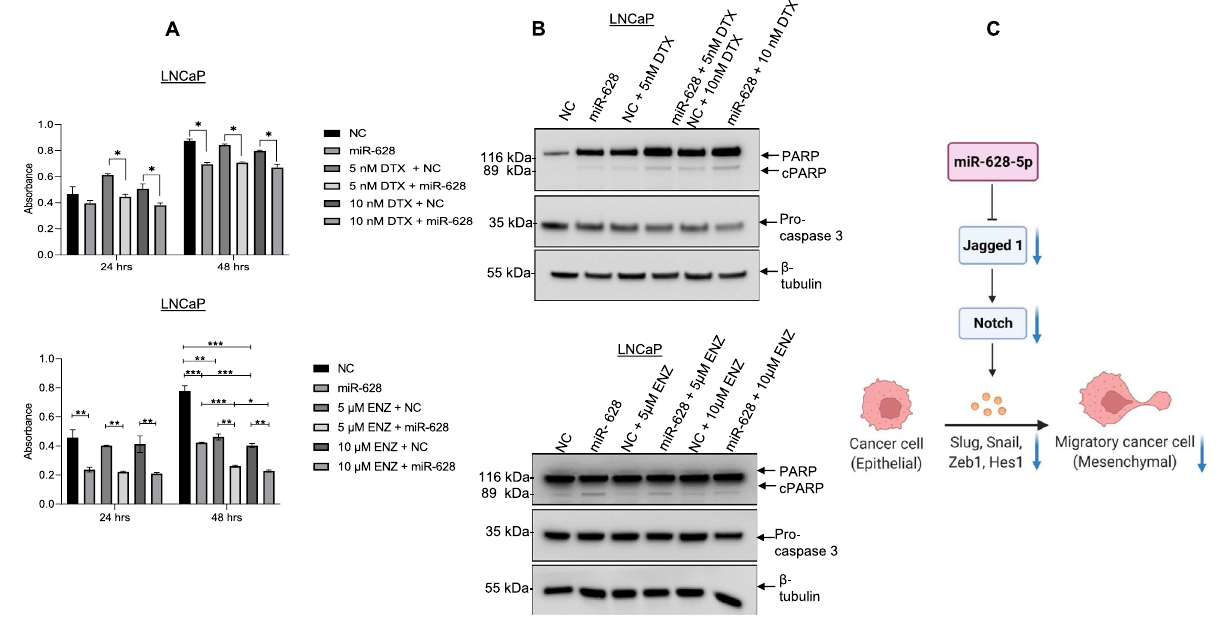
Figure 7. Overexpression of miR-628 and treatment of Enzalutamide or DTX decreases cell proliferation and induces apoptosis in LNCaP. ( A ) LNCaP cells transfected with miR-628 mimic or NC were treated with enzalutamide (ENZ) (5 µM, or 10 µM) or docetaxel (DTX) (5 nM or 10 nM). Cell viability was measured after 24 h and 48 h after transfection using MTT assay (*p < 0.05, **p < 0.01, ***p < 0.001). ( B ) The effect of miR-628 and co-treatment of ENZ or DTX on PCa cell apoptosis was assessed through cleaved-PARP and pro-Caspase-3 expression using western blotting as described in the materials and methods section. Membranes were cut before hybridization using the molecular weight marker as a reference and imaged using an Azure imaging system. All western blot full images are provided in supplementary information files. ( C ) Schematic model representing the anti-PCa role of miR-628. MiR-628 targets Jagged1 affecting Notch signaling and and Vimentin (0.61) compared to cells transfected with NC control (normalized to 1 for each protein) (Fig. 6F). Increased expression of ZEB1 has been shown to enhance motility and invasiveness, thus promoting an aggres- sive phenotype in PCa cells 34 . We also analyzed the expression of EMT markers E-cadherin and N-cadherin after overexpression of miR-628 by RT/qPCR (Fig. 6G) and immunoblotting (Fig. 6H). Overexpression of miR-628 decreased expression of N-cadherin mRNA levels in PC3 cells, but no significant changes were observed at the protein level. Transfection of miR-628 led to decreased protein expression of N-cadherin in LNCaP cells, but no significant changes were observed when mRNA was measured. Overexpression of miR-628 decreased expres- sion at both the mRNA and protein levels of E-cadherin in LNCaP cells and decreased its protein expression in PC3 cells (Fig. 6G,H). Since effective tumor growth and eventual metastasis are dependent on angiogenesis 35 , we next investigated the role of miR-628 in angiogenesis (Fig. 6I). HUVEC cells were transfected with miR-628 mimic or NC mimic for 24 h, cells were re-plated on matrigel coated plates, and vascular tube formation was